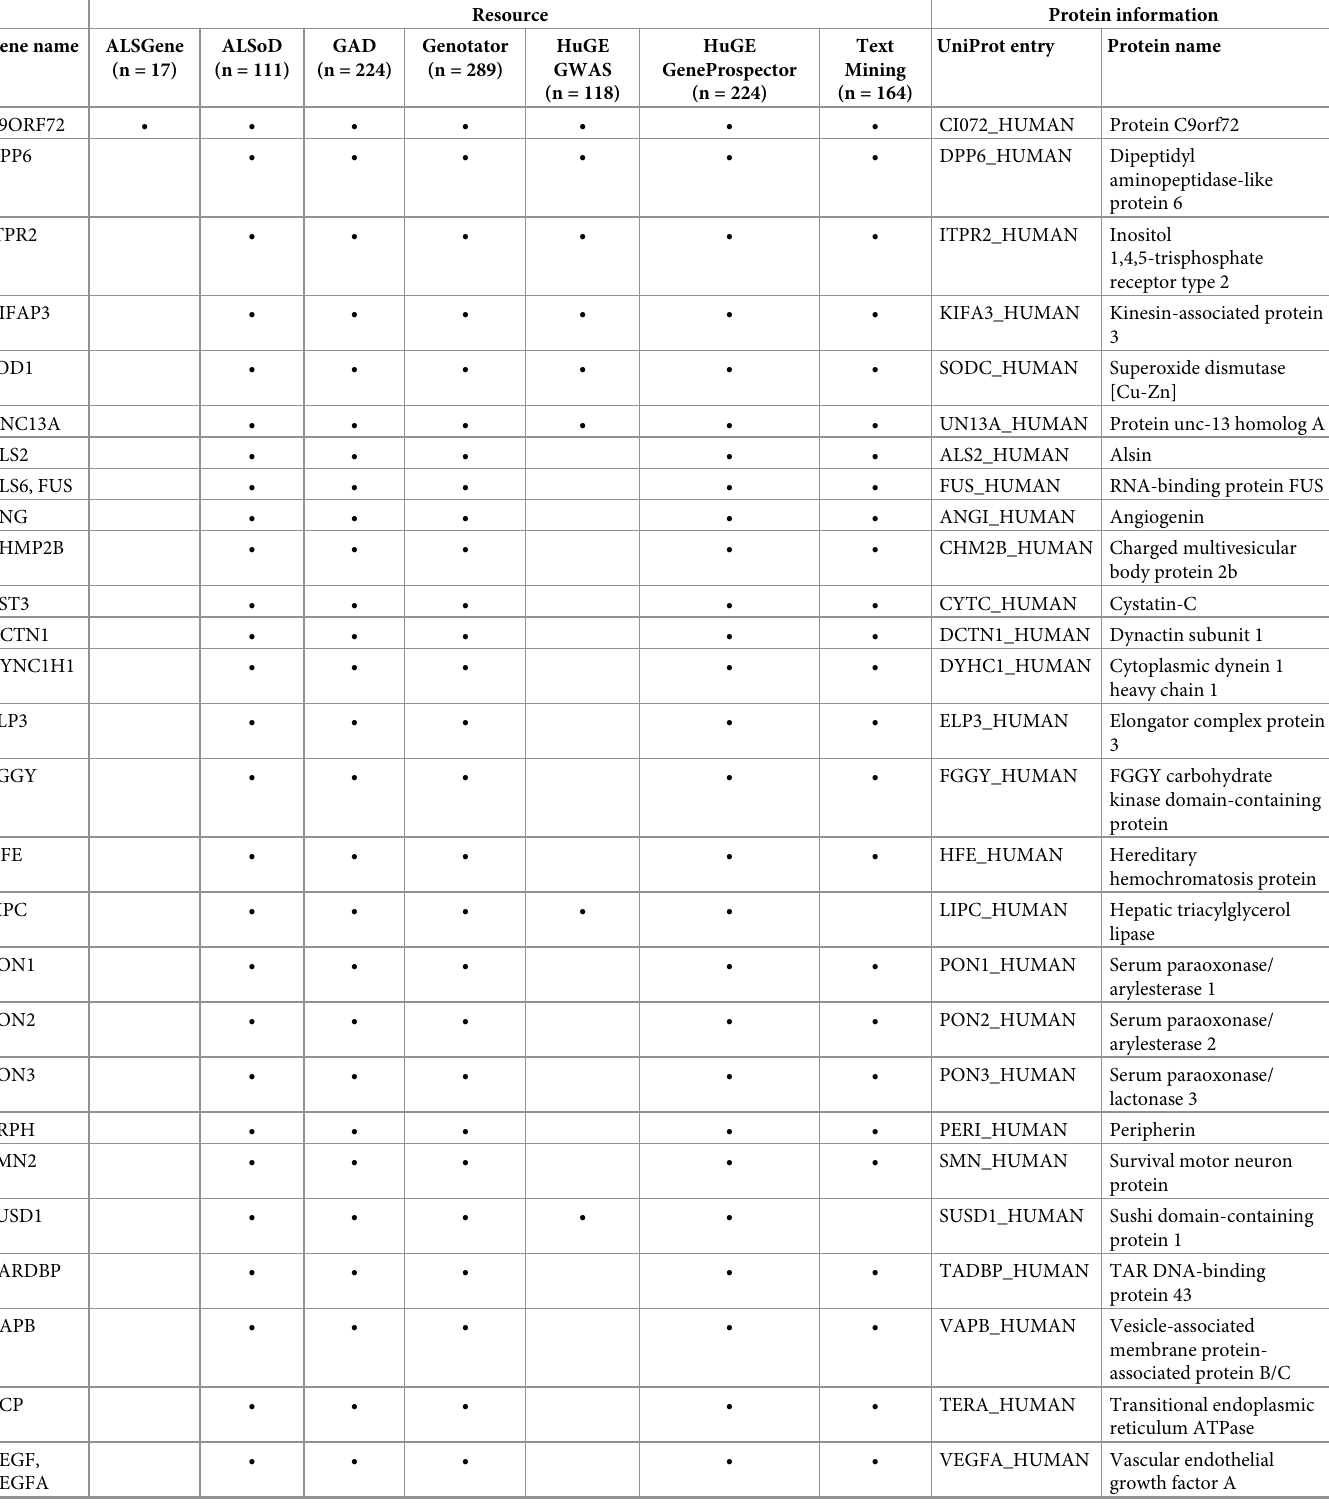
Table 1. ALS-associated genes/proteins supported by 5 or more